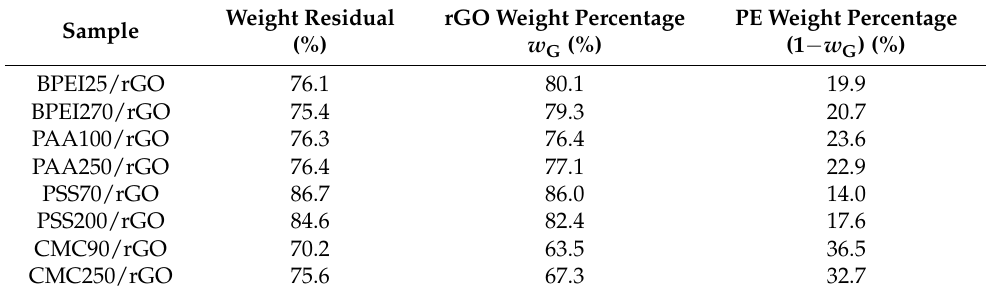
Table 2. Weight residual of PE/rGO after TG and the weight percentages of rGO and PE in PE/rGO films.